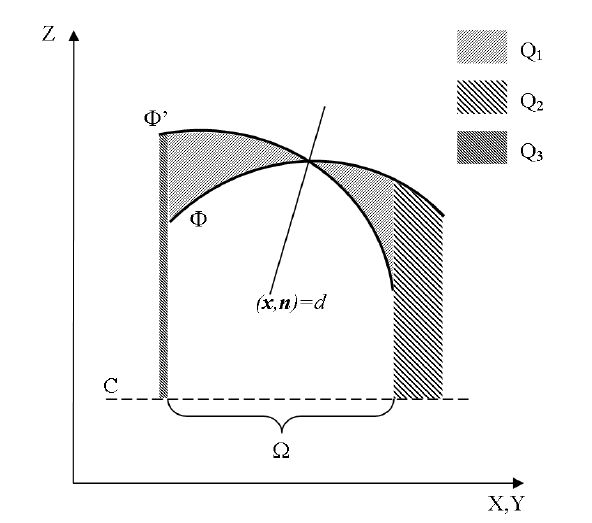
Figure 9. Distance to a